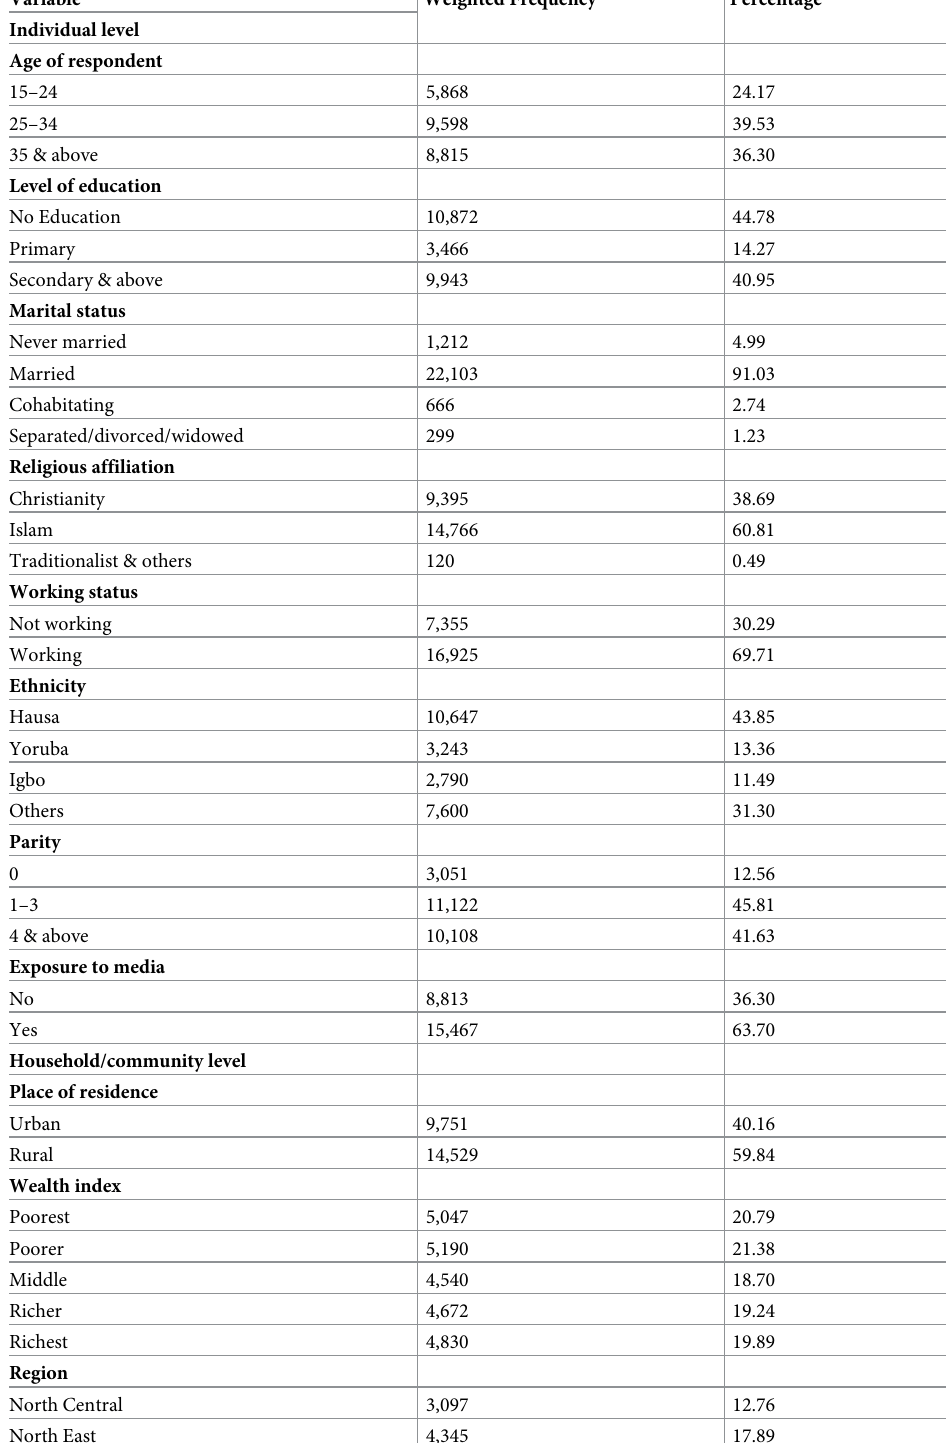
Table 1. Individual and household/community level characteristics of reproductive age women in Nigeria (n =